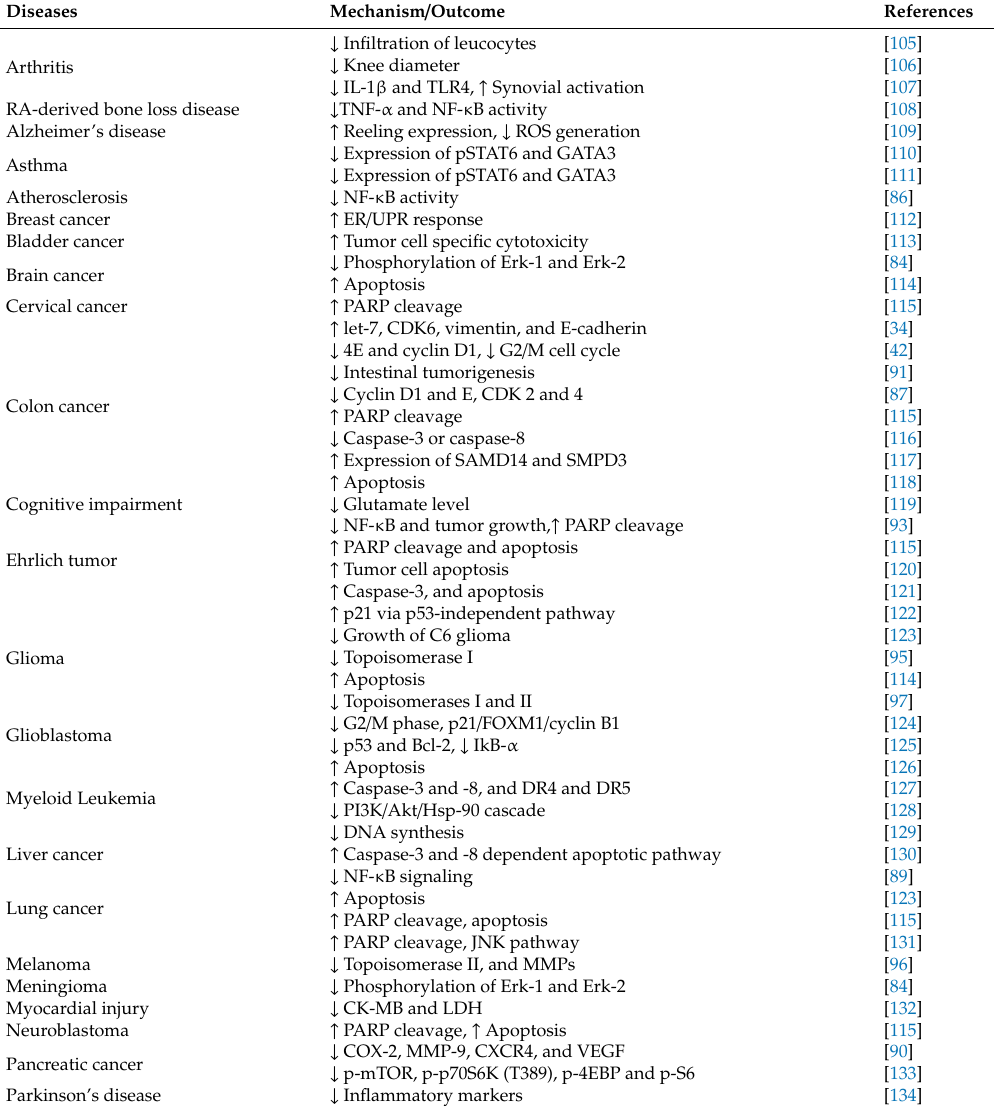
Table 1. Biological activity of boswellic acid against di ff erent